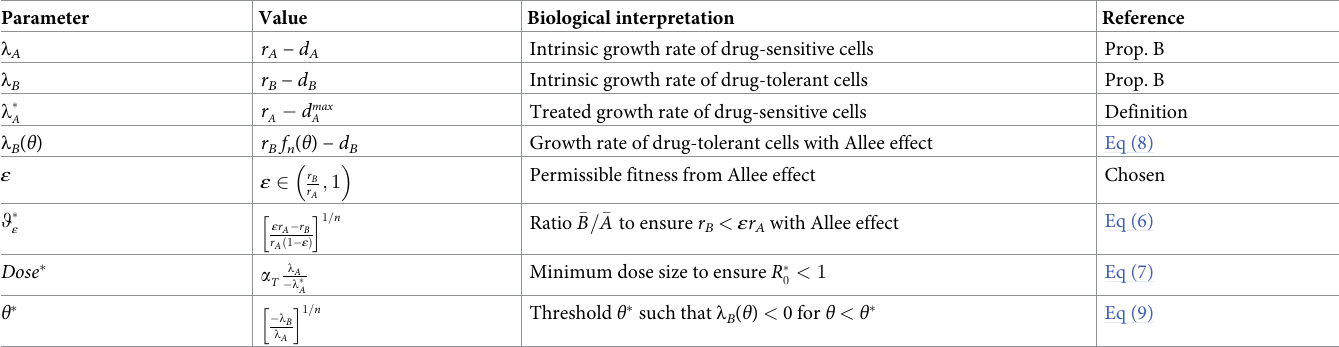
Table 1. Summary of analytical expressions used to determine model-informed